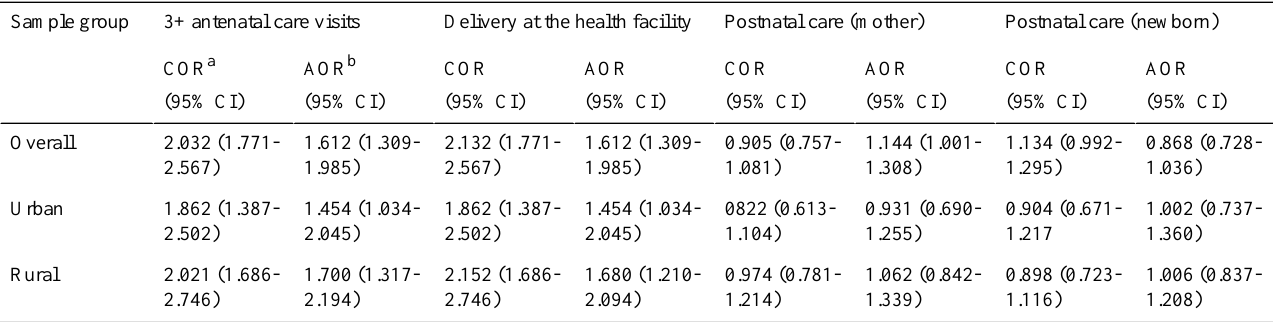
Table 3. Odds ratios of attending at least 4 antenatal care visits and facility delivery among those who reported using mobile phone for health care